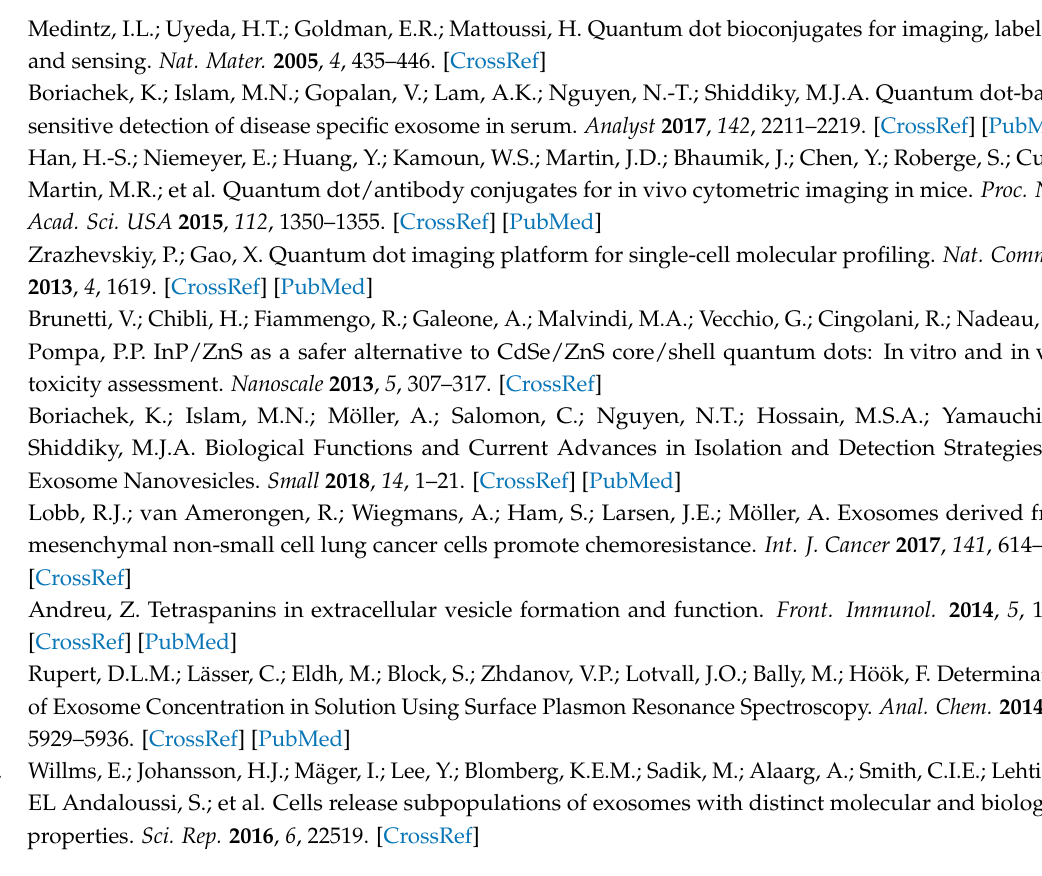
Figure S1: Absorption and fluorescence of the InP/ZnS-Oleylamine, InP/ZnS-MSA and InP/ZnS-AntiCD63. Figure S2: FTIR spectra of Oleylamine, MSA and Anti-CD63. Figure S3: Immobilisation of the secondary antibody to the CM3 chip. Figure S4: Response after injection of the THP-1 derived exosomes onto the secondary